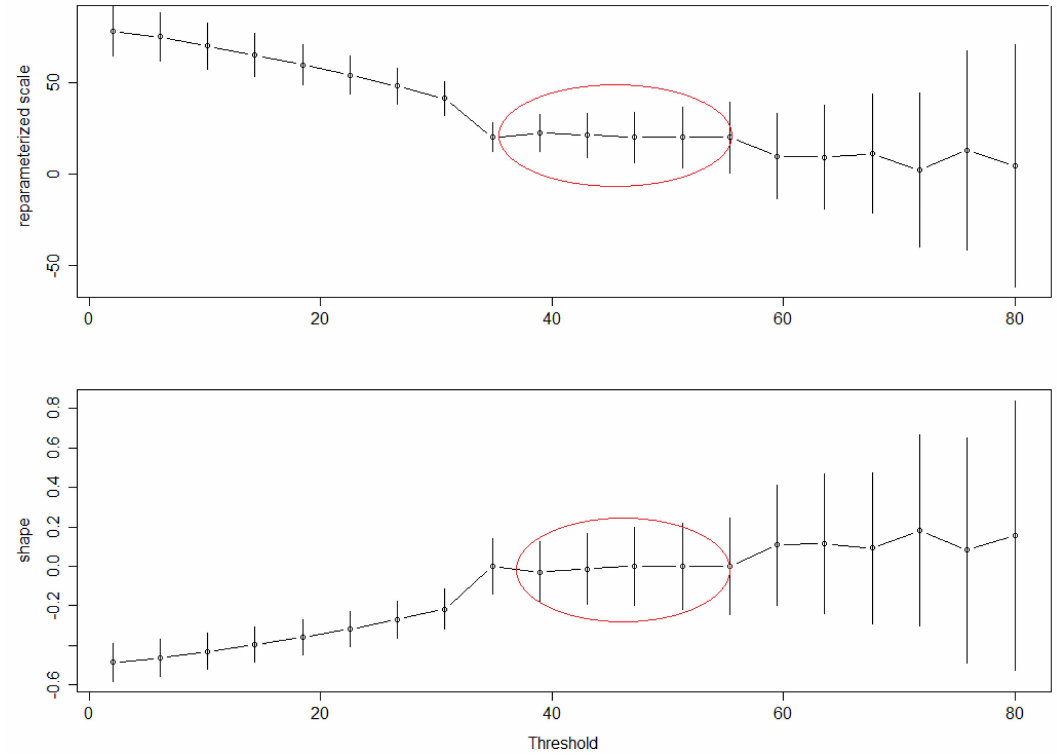
Figure A10. Parameter estimates against threshold for daily rainfall data at Pira